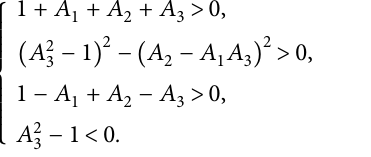
Figure 6. From Figures 5 and 6, when α punov exponents are negative, which means that the Nash equilibrium point E